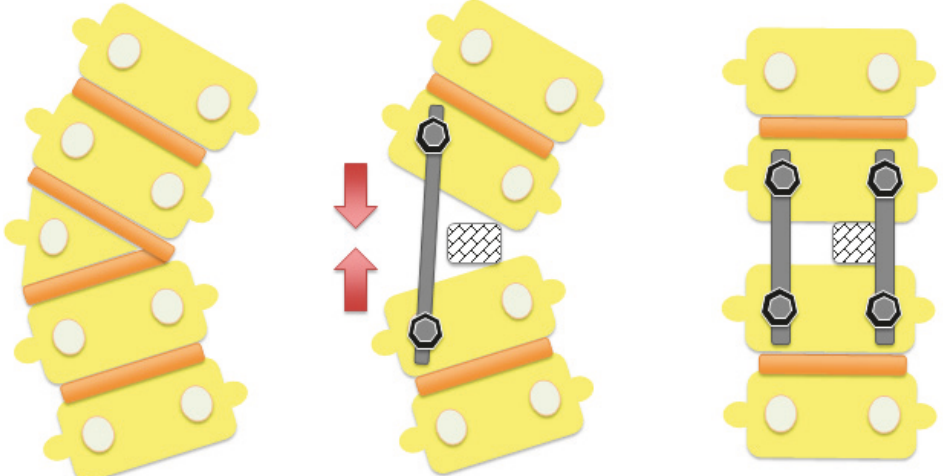
Figure 2: Correction of the coronal plan deformities using mesh cage after hemivertebra